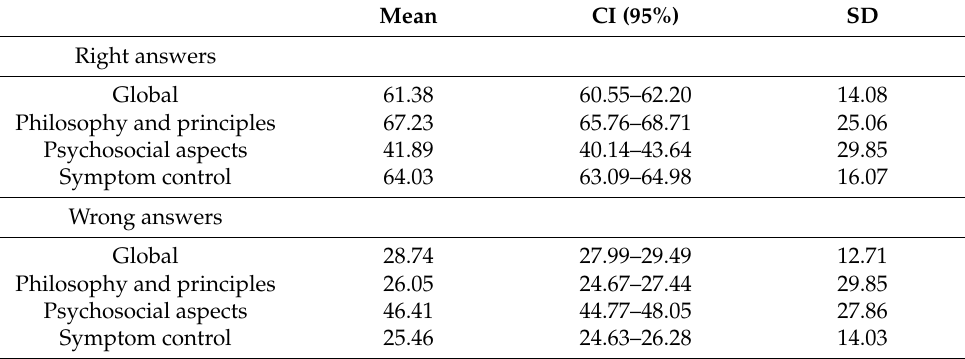
Table 3. Percentages of right and wrong answers in global PCQN-SV and its three subscales.